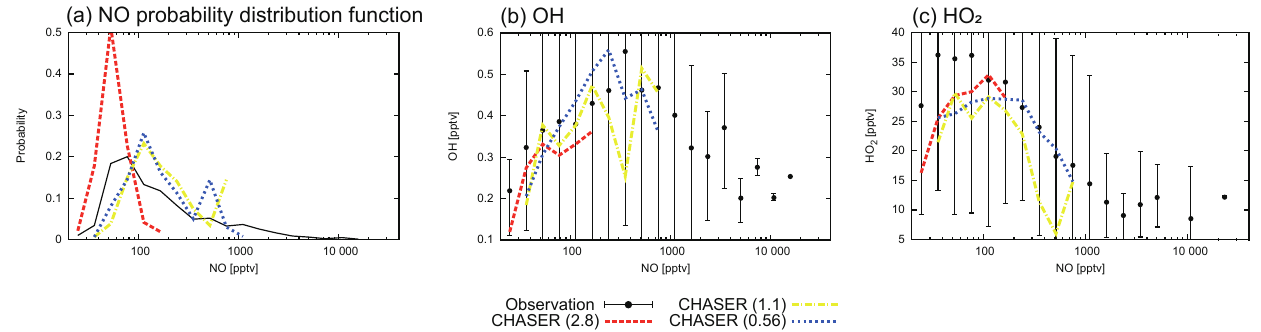
Figure 11. (a) Probability distribution functions of NO, (b) OH, and (c) HO 2 as a function of NO (pptv). The black dots represent measure- ments, the red dashed line is the model simulation at 2.8 ◦ resolution, the yellow dashed-dotted line is the model simulation at 1.1 ◦ resolution, and the blue dotted line is the model simulation at 0.56 ◦ resolution. The vertical bars represent the standard deviation of the measurements.